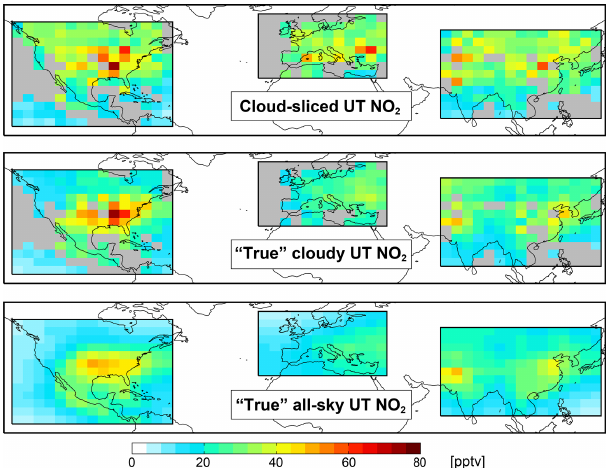
Figure 1. Comparison of synthetic cloud-sliced and true NO 2 in the upper troposphere (UT) for June–August 2016–2017. Maps show UT NO 2 at 4 ◦ × 5 ◦ from cloud-slicing GEOS-Chem partial columns above all clouds with cloud-top pressures at 450–180hPa (top), as grid-average mixing ratios from GEOS-Chem for the same scenes as are cloud-sliced (middle), and for all-sky (clear and cloudy) scenes (bottom). Data are Gaussian-weighted to the pressure cen- tre (315hPa). Grey grids have < 5 data points.